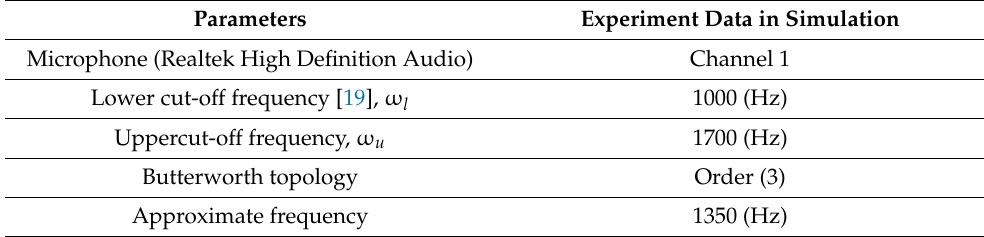
Table 1. Parameters used in this experimental.